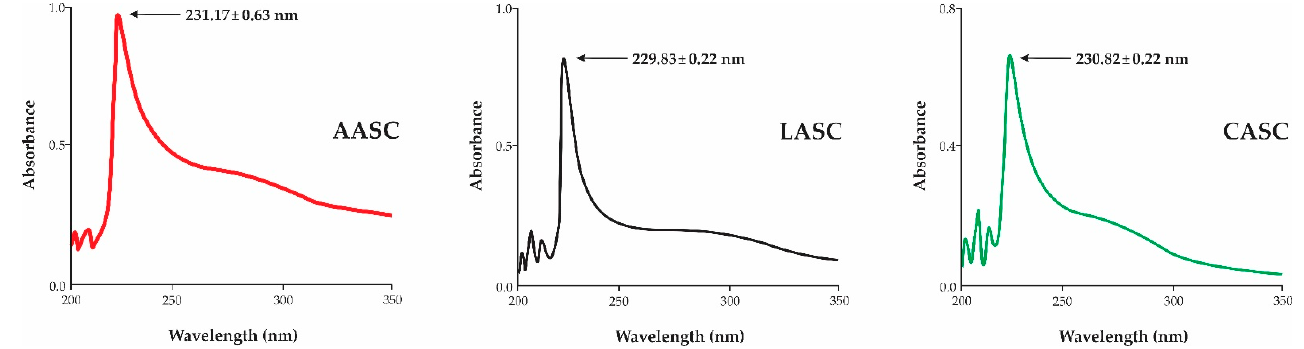
Figure 2. UV absorption spectra of acid soluble unicornfish ( N. reticulatus ) bone collagen.